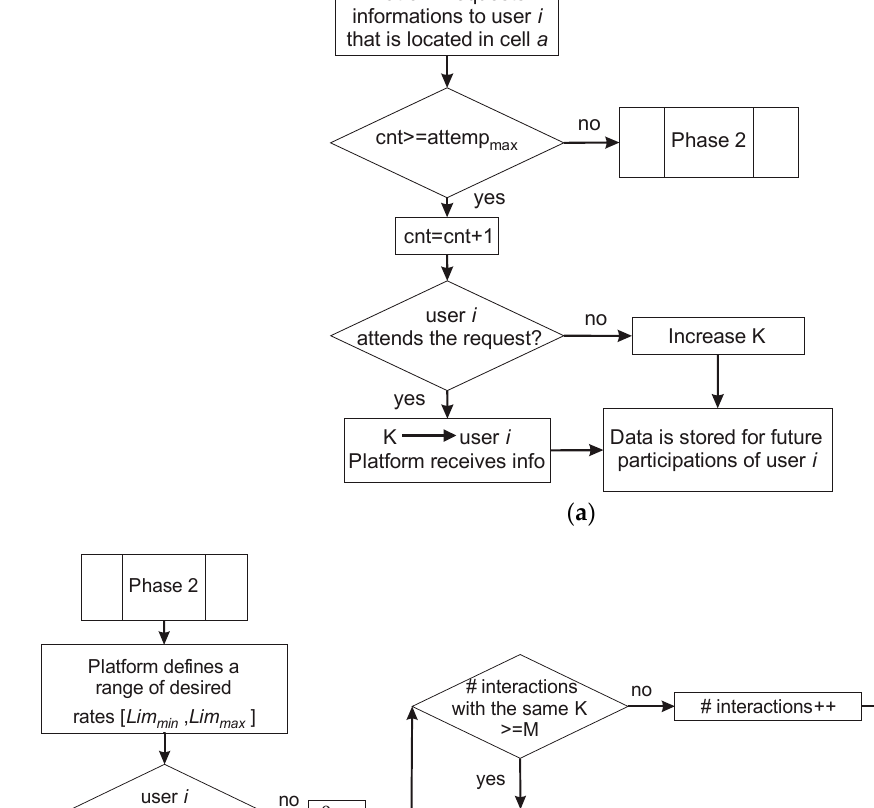
14 of 28 Figure 9. Beta distributions with different 𝛼 and 𝛽 .